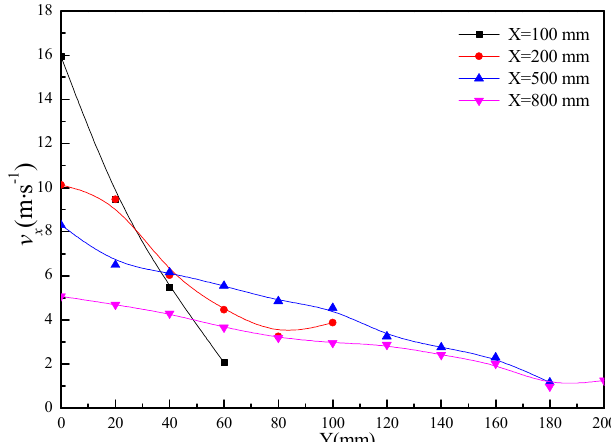
Figure 10. Comparison curve of the axial velocity along the radial direction.